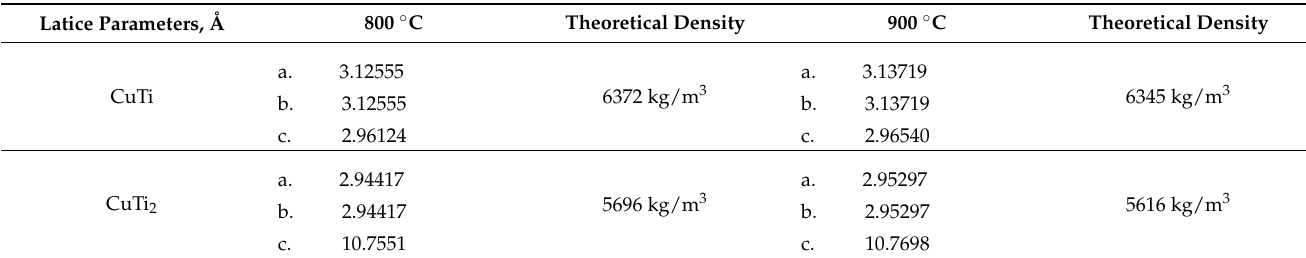
Table 3. Crystallography parameters of specimens.